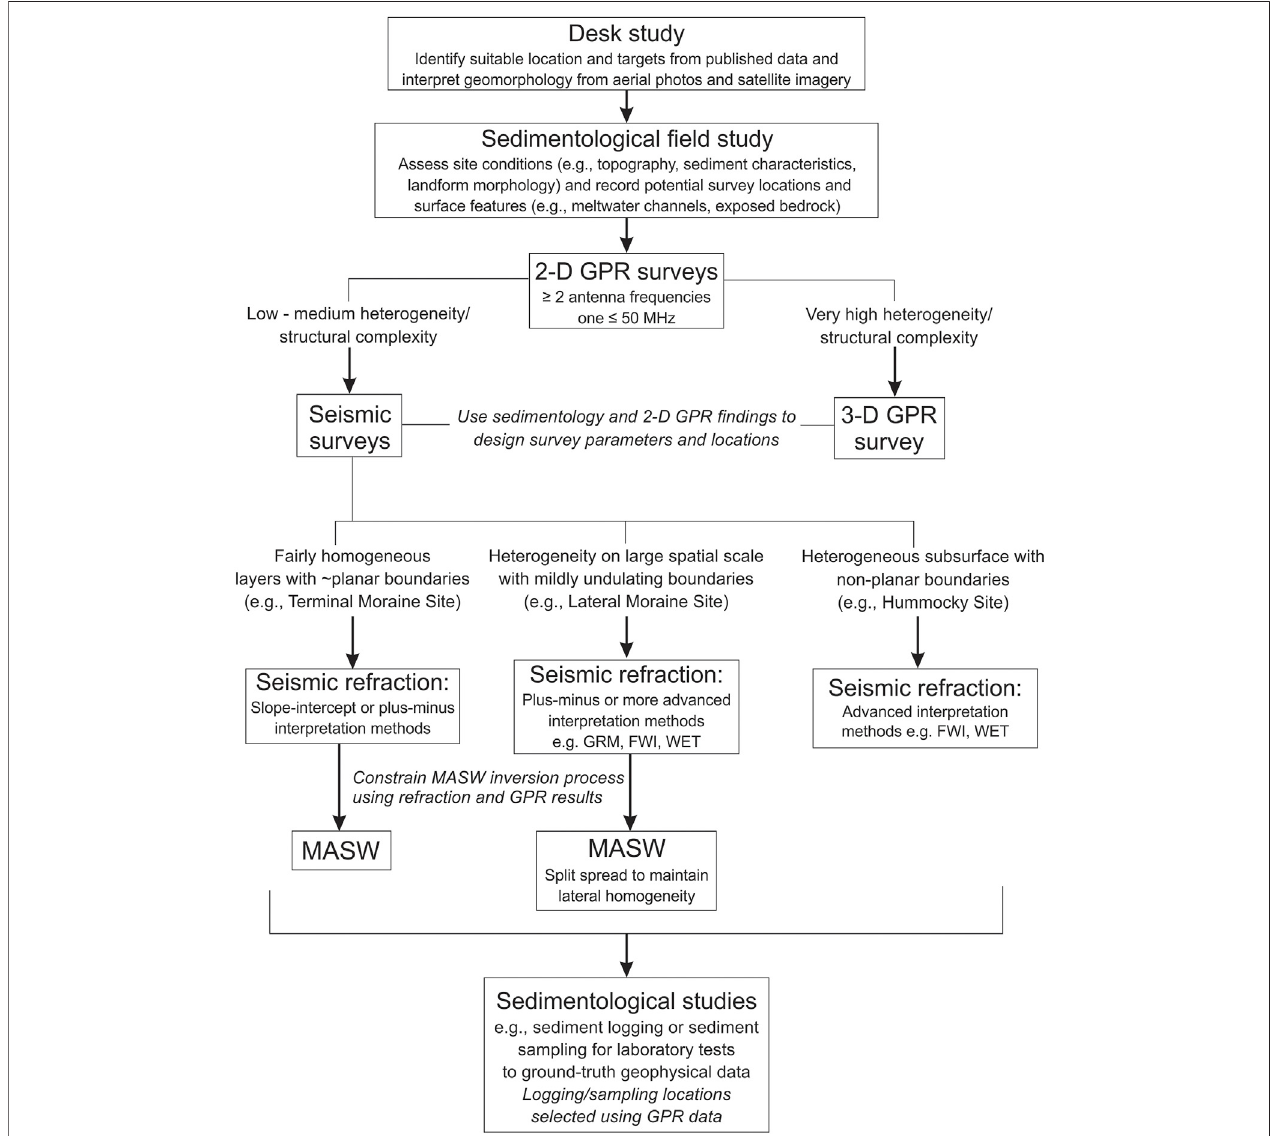
FIGURE 12 | Suggested work fl ow for undertaking combined GPR, seismic refraction, and MASW surveys in a proglacial environment.